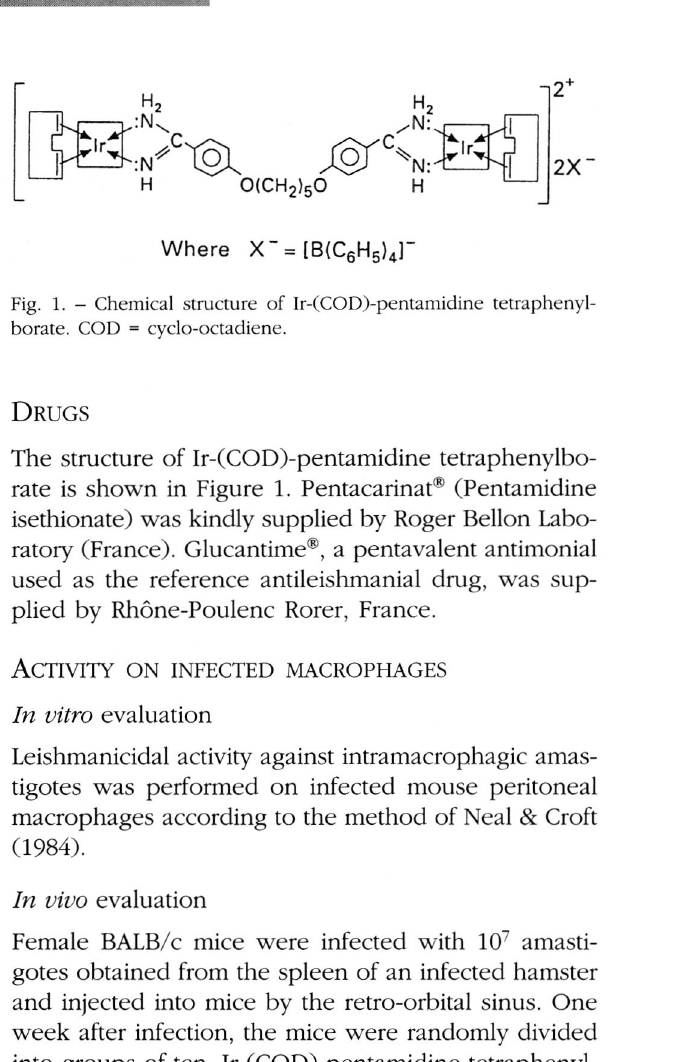
Fig. 1. - Chemical structure of Ir-(COD)-pentamidine tetraphenyl- borate. COD = cyclo-octadiene.